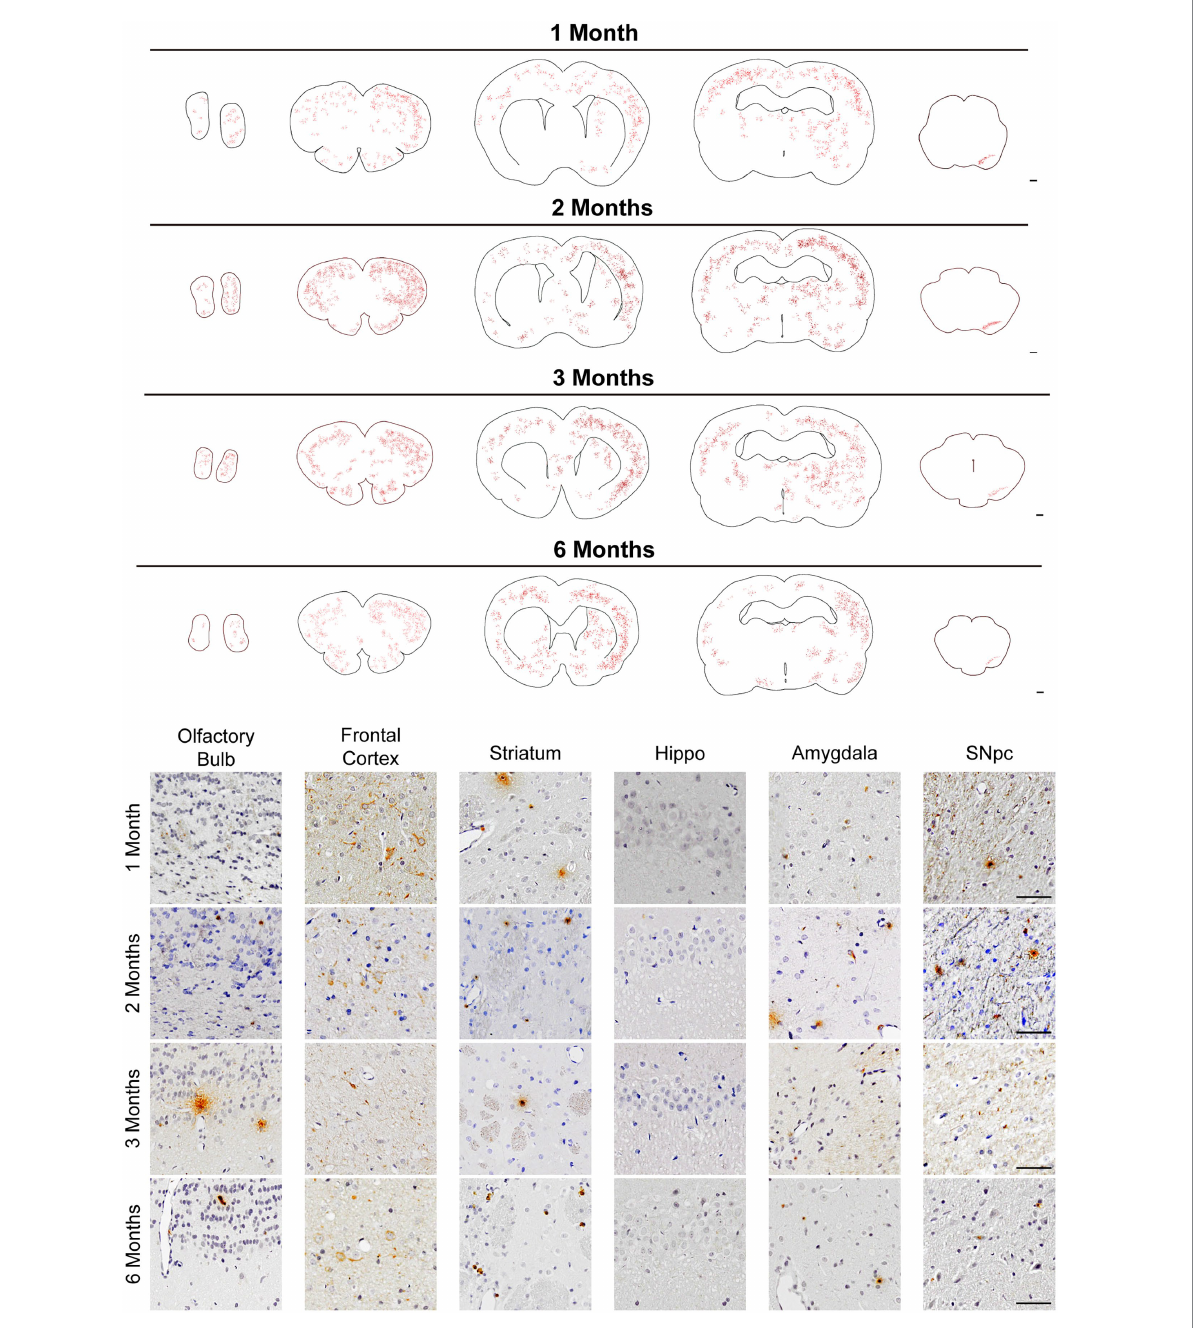
FIGURE 2 pSyn pathology spread throughout brain regions interconnected with the striatum. (Top) Schematics of representative sections throughout the rat brain, and inclusions were showed with red dots. Scale bar = 500 μ m. pSyn aggregates spread to the anatomically connected brain regions including the SNpc, amygdala, cortex, and olfactory bulb. (Bottom) Micrographs from regions with prevalent pSyn aggregates at 1, 2, 3, and 6 months post-injection. Scale bar = 50 μ